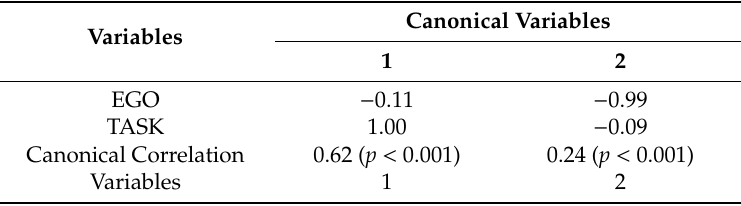
Table 3. Loadings for canonical